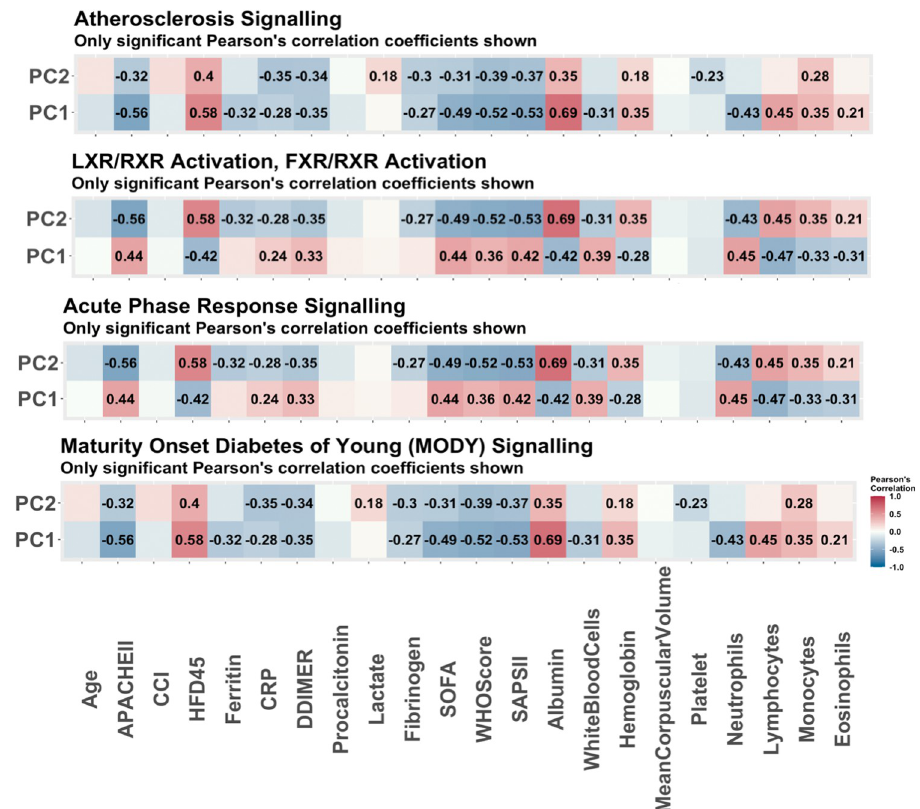
Fig 10. The Pearson correlations of principal components of pathways associated with disease severity (COVID- 19 patients). The Pearson correlations of the principal components used to summarize the enriched pathways with COVID-19 severity as predicted by IPA. These are the pathways predicted to be enriched based on the 62 proteins determined to be significant in COVID-19 severity via stability selection which were able to be mapped to known pathways. Only the correlations which were significant (p-value < 0.05) are reported. These pathways have many strong correlations with clinical covariates.